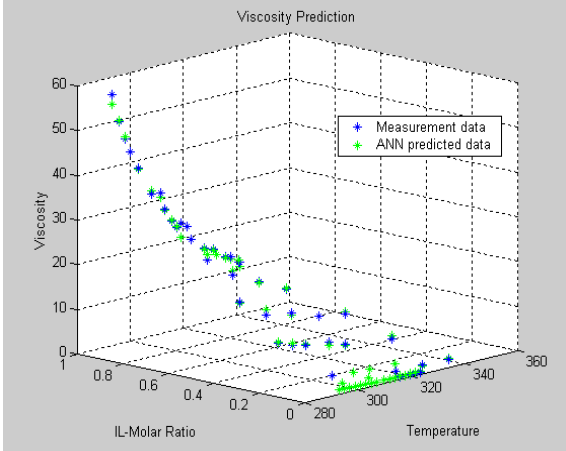
Fig. 5.3. Viscosity for [C 4 -mim][NTf 2 ]-ethanol binary mixtures at the temperature range T=293-328K in terms of different molar